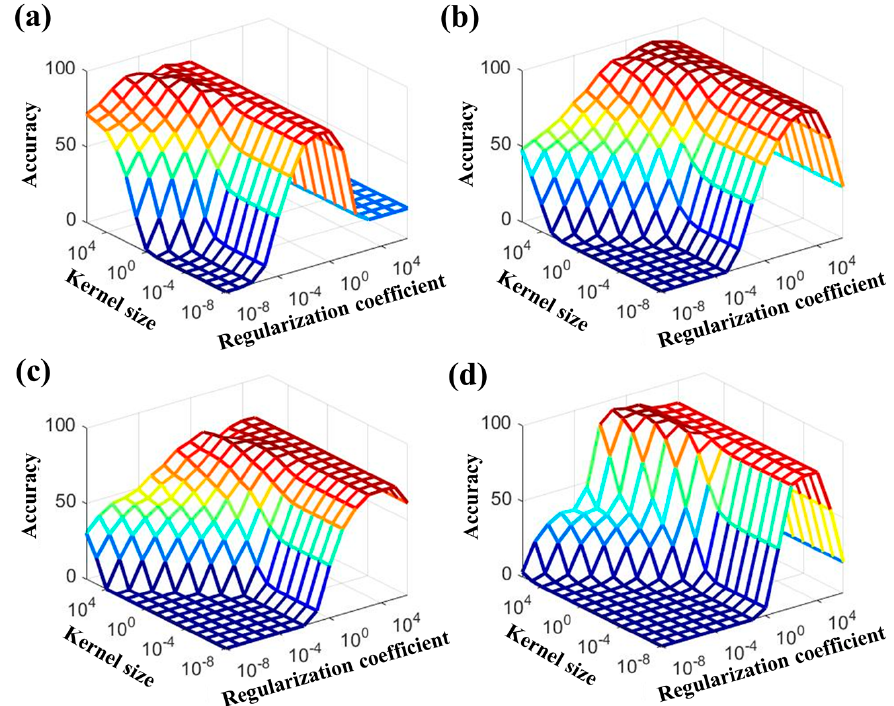
Figure 4. Variation of averaged accuracy with respect to the regularization coefficient and kernel size: ( a ) HRV + K-ELM; ( b ) SC + K-ELM; ( c ) SKT + K-ELM; and ( d ) IT + K-ELM. Table 3. Classification rates of K-ELM with HRV features (HRV + K-ELM).